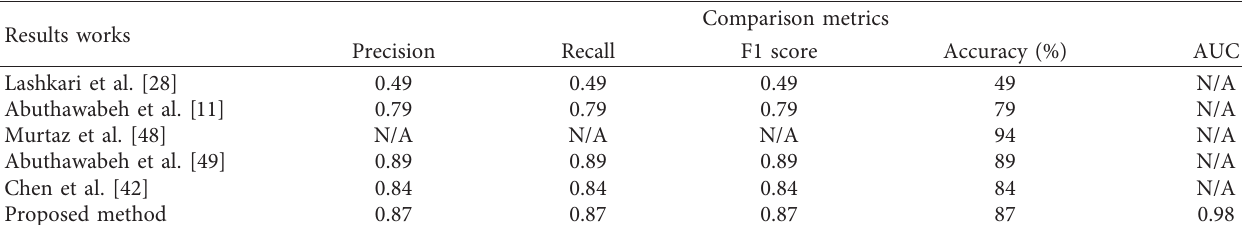
Table 14: Result of performance evaluation and comparison metrics in multiclass